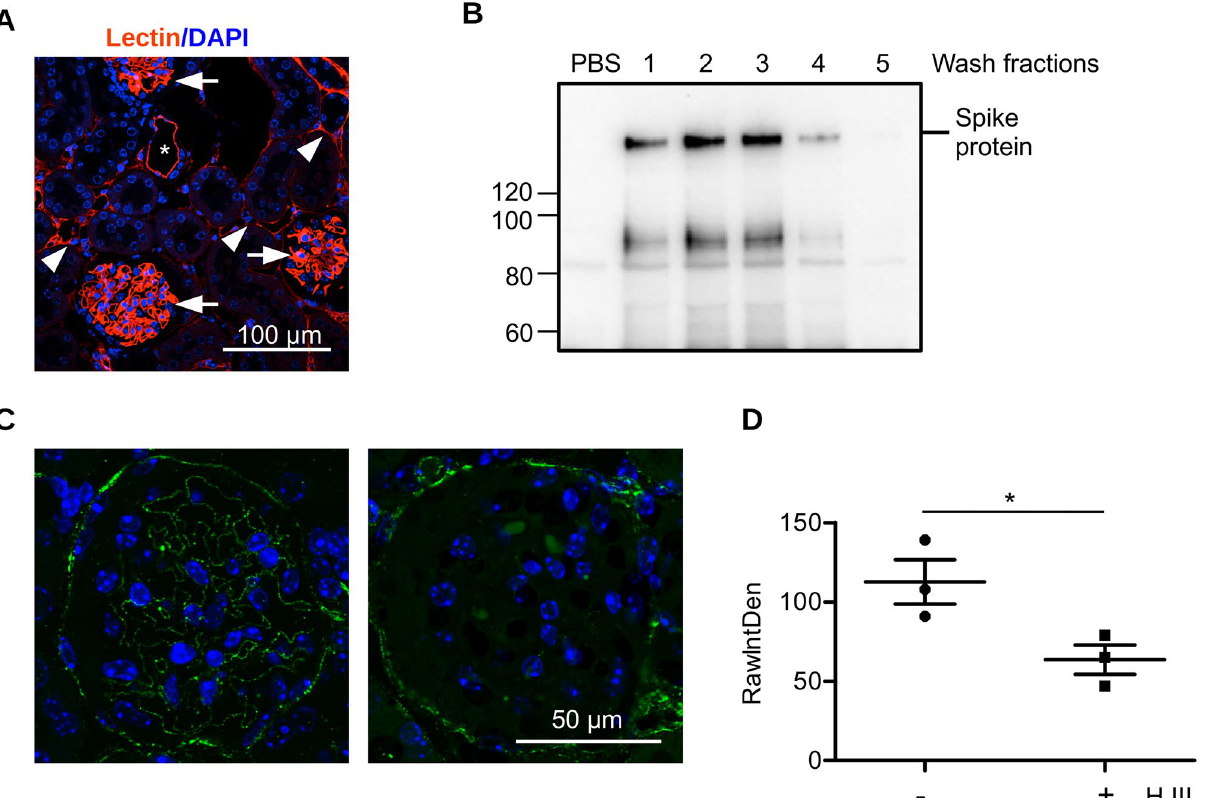
Figure 6. Ex vivo kidney perfusion system. ( A ) Mouse kidney were perfused ex vivo with lectin. Perfusion of glomeruli (arrows), artery (asterisks), and peritubular capillary (arrowheads) was achieved. ( B ) Mouse kidney were perfused with 15 µg/ml of recombinant SARS-CoV-2 spike protein in PBS for 30 min. Then, the kidney were washed with PBS and perfusate was collected in fraction (1–5). Then, kidney were frozen in liquid nitrogen for biochemical assay of spike protein and fixed for immunohistochemistry. ( C ) Paraffin-embedded kidney slices of the perfused kidney (left) and the kidney perfused with Heparinase III (right) stained for HS and DAPI. ( D ) Quantification of HS expression in the kidney glomeruli without and with Heparinase III treatment.